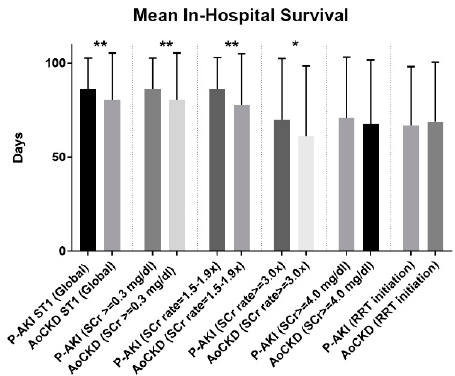
Figure 5. Mean in-hospital survival time (days) by baseline renal function and KDIGO AKI stage and criteria. P-AKI: Pure acute kidney injury. AoCKD: Acute-on-chronic kidney disease. AKI: Acute kidney injury. ST1: AKI stage 1. ST2: AKI stage 2. ST3: AKI stage 3. SCr: Serum creatinine. RRT: Renal replacement therapy. * p < 0.05; ** p < 0.01.